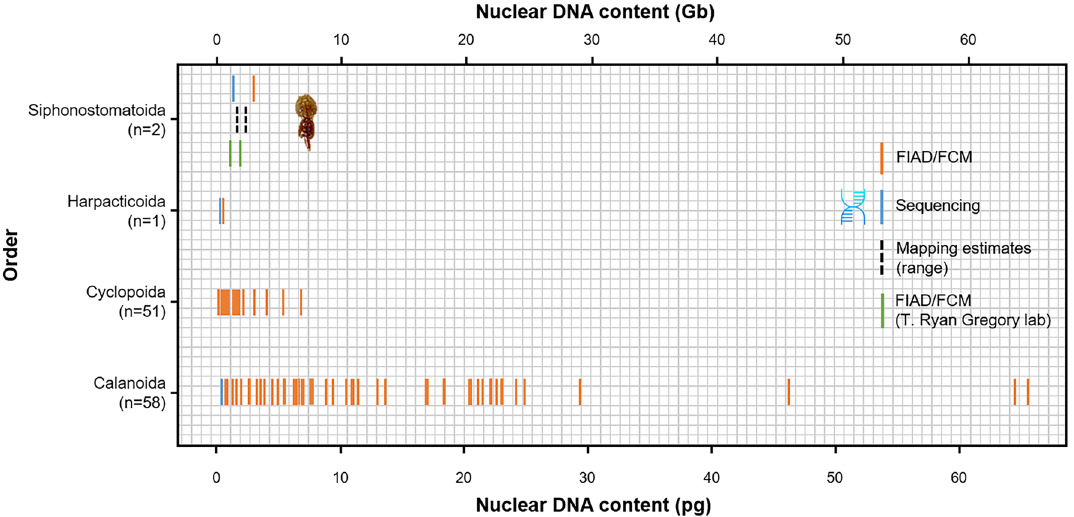
Figure 3. Somatic nuclear DNA contents of copepods. Each species is represented by a vertical bar. Estimates based on cytometric methods, genome assemblies, and mapping are presented in orange, blue, and dotted black, respectively, for the siphonostomatoid L. salmonis salmonis . The black dotted lines depict a range of values obtained for L. salmonis salmonis using mapping. FIAD and FCM measurements depicted by green vertical lines for L. salmonis salmonis are from Gregory 53 and Jeffery 54 , respectively. FIAD (orange) and genome assembly (blue) estimates are shown for the harpacticoid T. californicus 63,64 . FIAD (orange) and genome assembly